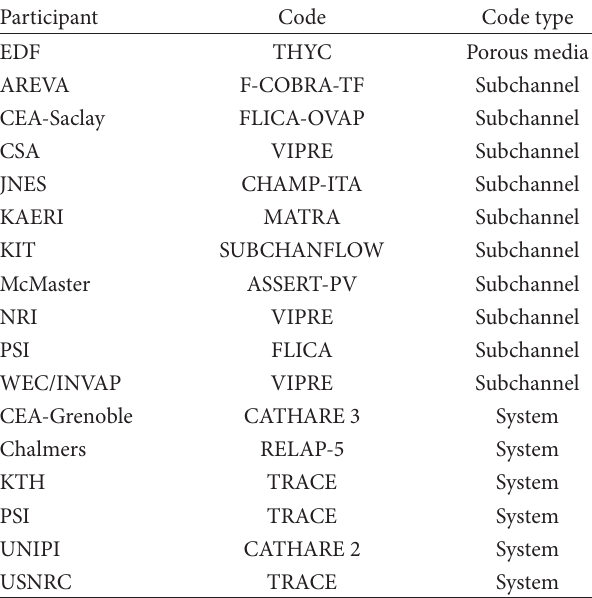
Table 15: Phase I, exercise 2 participants and code list.